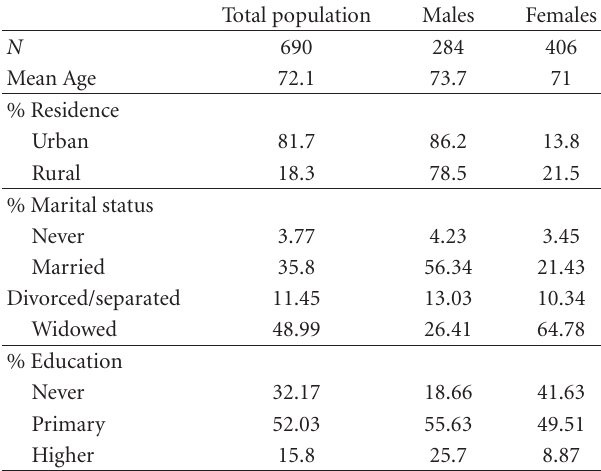
Table 1: Description of sample of elderly Zambians (60 years and